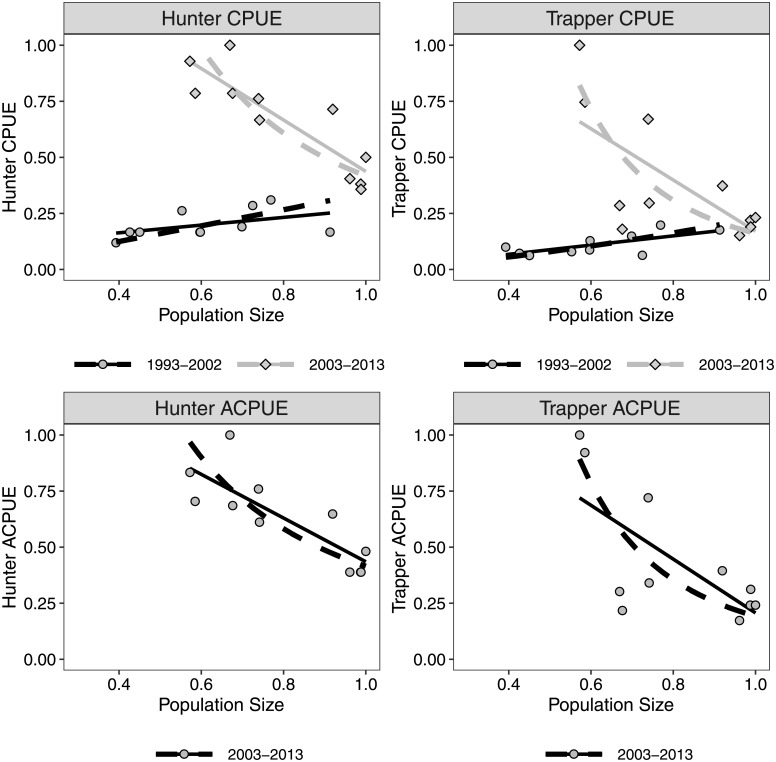
Estimated relationships between catch-per-unit-effort (CPUE) and actual catch-per-unit-effort (ACPUE) for bobcat hunters and trappers in Wisconsin and estimated bobcat abundance.Solid lines are estimated fits from linear regression models while dashed lines are estimated fits from reduced major axis regression of the log of CPUE/ACPUE against the log of abundance. The dependent and independent variables have been rescaled by dividing by the maximum value.